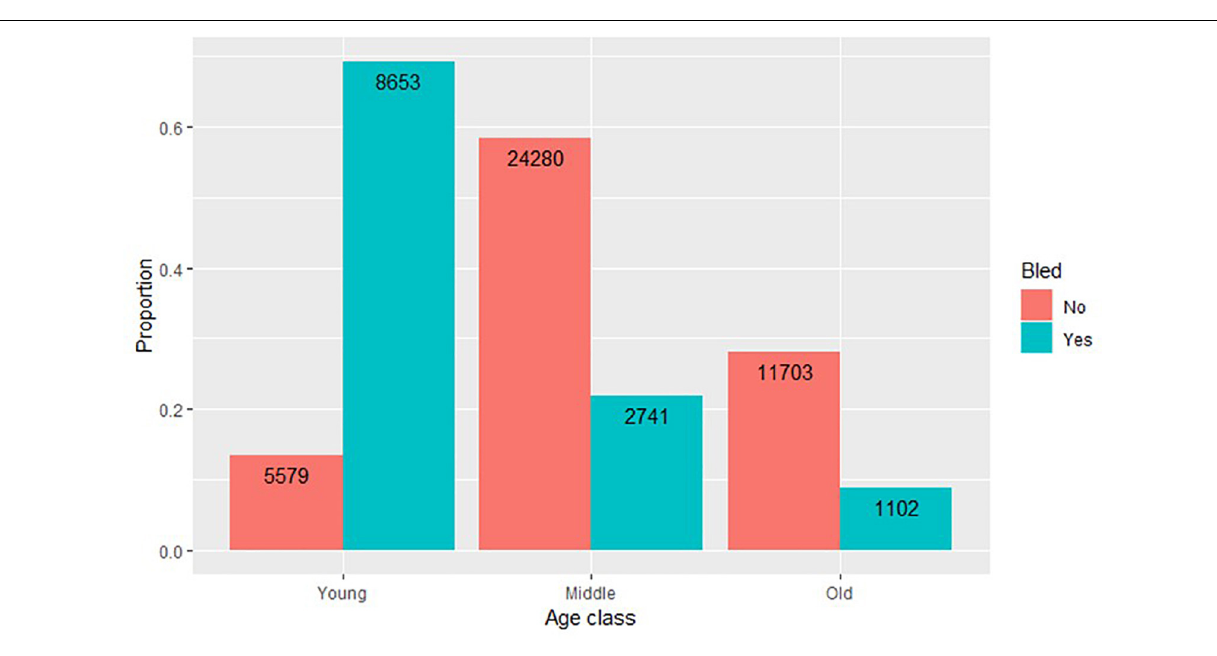
FIGURE 5 | Age distribution for tagged horseshoe crabs. Age was recorded sporadically. Bled crabs were aged only from 1999 to 2002 and in 2004. Most unbled crabs were aged in Delaware Bay from 2003 to 2005 and in coastal areas from 2013 to